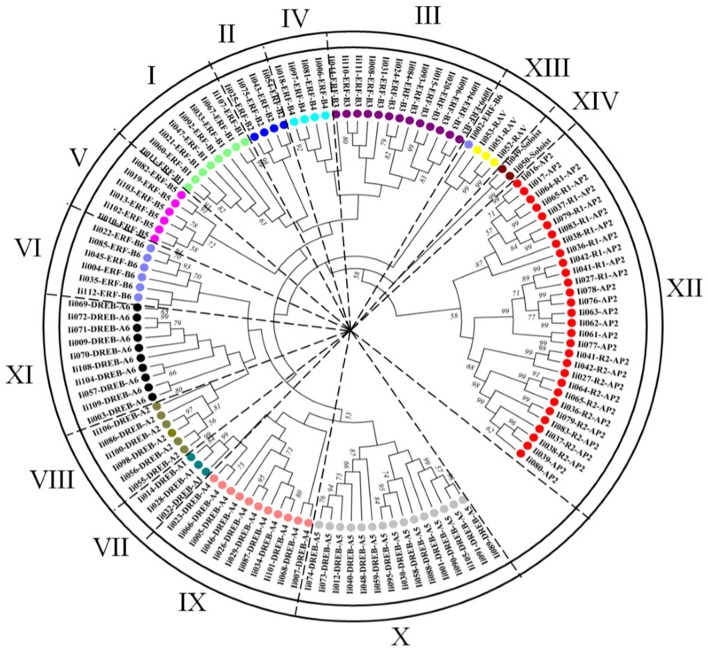
Phylogenetic analysis of the I. indigotica AP2/ERFs family. The phylogenetic tree of AP2/ERF transcription factor domains identified in I. indigotica was constructed using the neighbor-joining approach with 1000 bootstrap repetitions. Based on the topology of the generated phylogenetic tree it can be inferred that the AP2/ERFs family of I. indigotica is divided into 14 groups (I–XIV, without DREB-A3), containing the ERF (DREB and ERF subfamilies), AP2, RAV, and Soloist families. Different subfamilies are color coded.